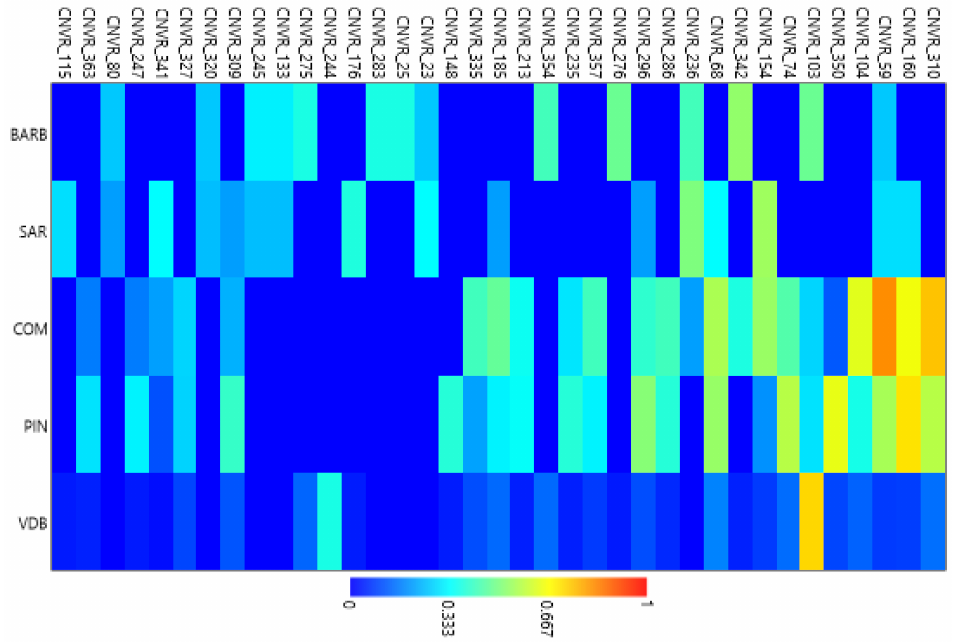
Figure 5. Heatmap analysis based on hierarchical cluster using top 10% of CNVRs in the five sheep breeds. Barbaresca (BARB), Comisana (COM), Pinzirita (PIN), Sarda (SAR), and Valle del Bel ì ce (VDB). Table 3. Pairwise PhiPT genetic distances among the five breeds. BARB COM PIN SAR VDB BARB 0.000 COM 0.255 0.000 PIN 0.264 0.077 0.000 SAR 0.220 0.196